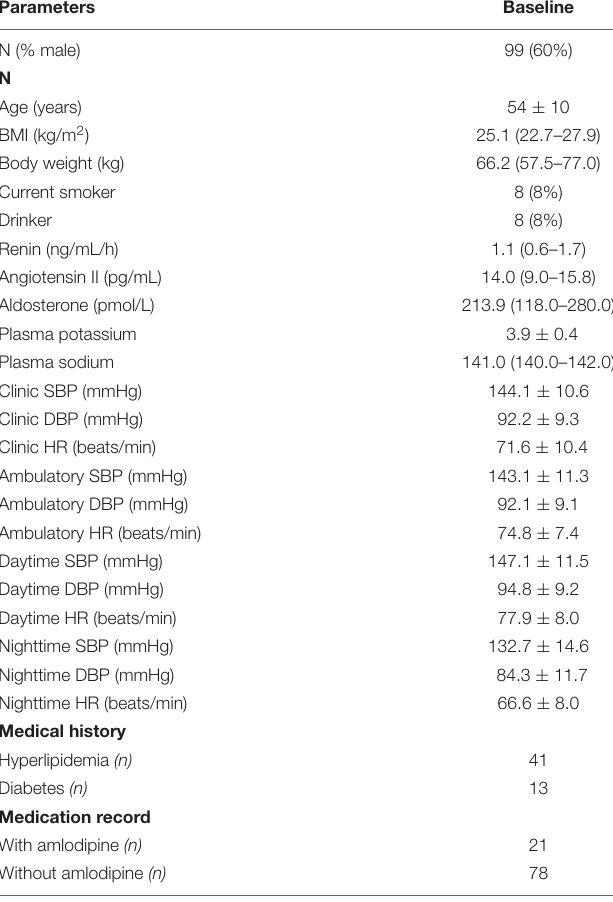
TABLE 1 | Baseline characteristics of the study population.